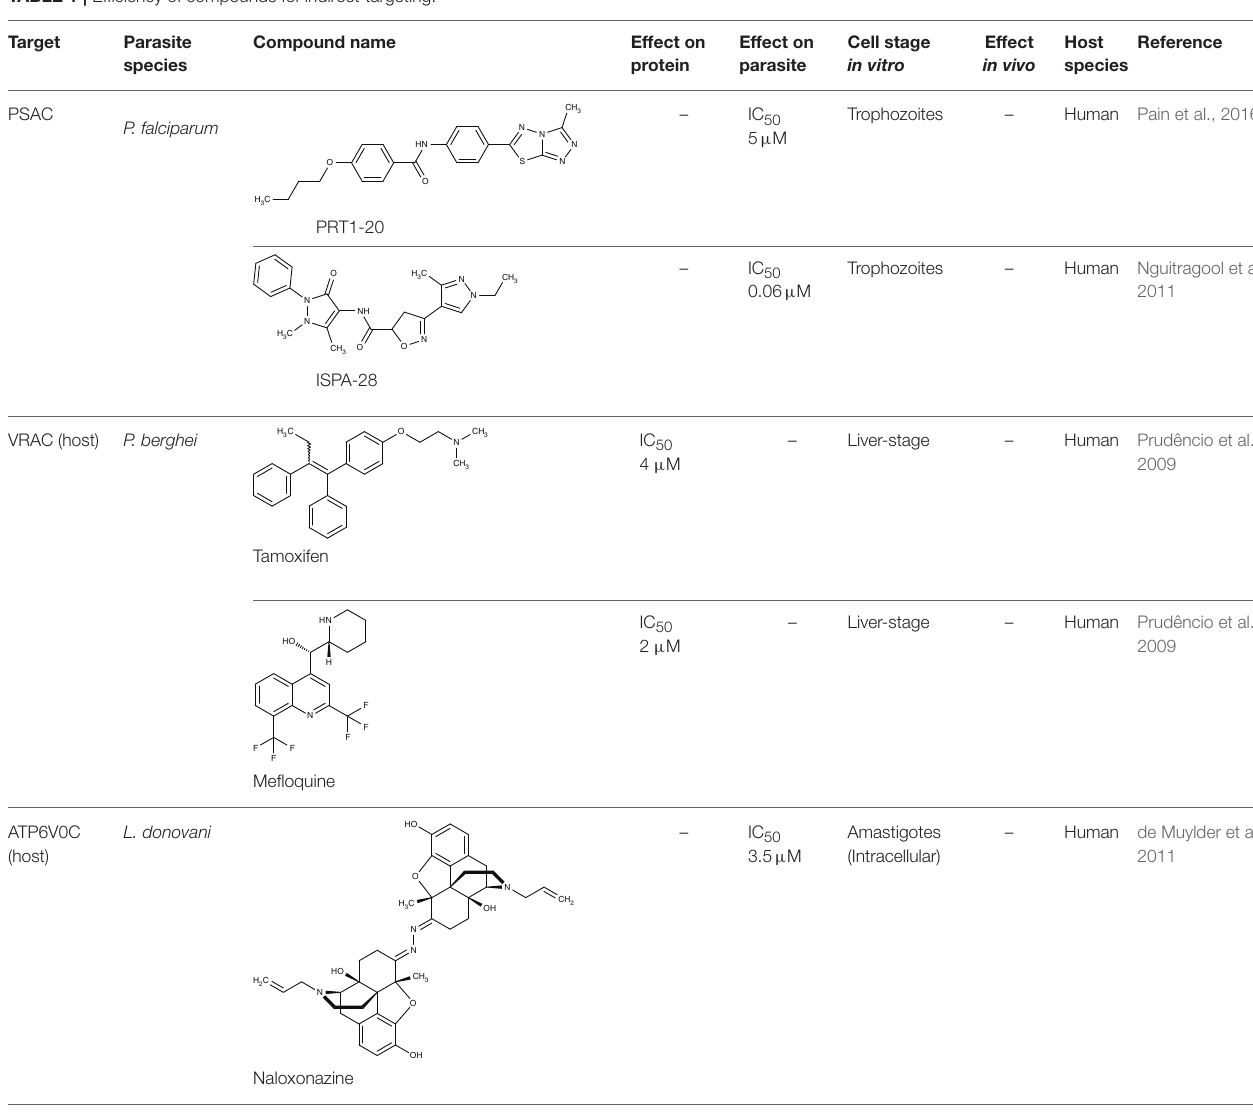
TABLE 1 | Efficiency of compounds for indirect